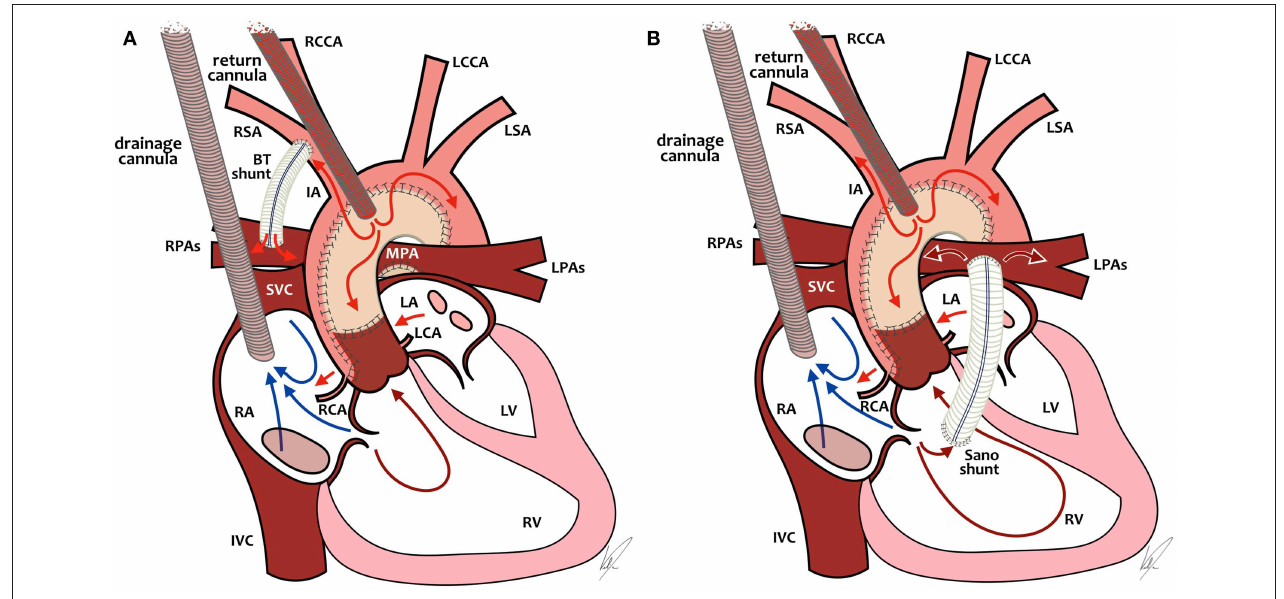
FIGURE 2 | ECMO cannulation and preferential ECMO flows in single-ventricle patients with BT-shunt ( A , left) or Sano-shunt ( B , right). In both diagrams (A, B) , the arterial cannula is placed in the neoaorta, but it can also be placed through the carotid artery or in the innominate artery. RCCA, right common carotid artery; LCCA, left common carotid artery; LSA, left subclavian artery; RSA, right subclavian artery; IA, innominate artery; RPAs, right pulmonary arteries; LPAs, left pulmonary arteries; MPA, main pulmonary artery; SVC, superior vena cava; IVC, inferior vena cava; RA, right atrium; LA, left atrium; RCA, right coronary artery; LCA, left coronary artery; RV, right ventricle; LV, left ventricle. Drawings by Marta Velia Antonini.